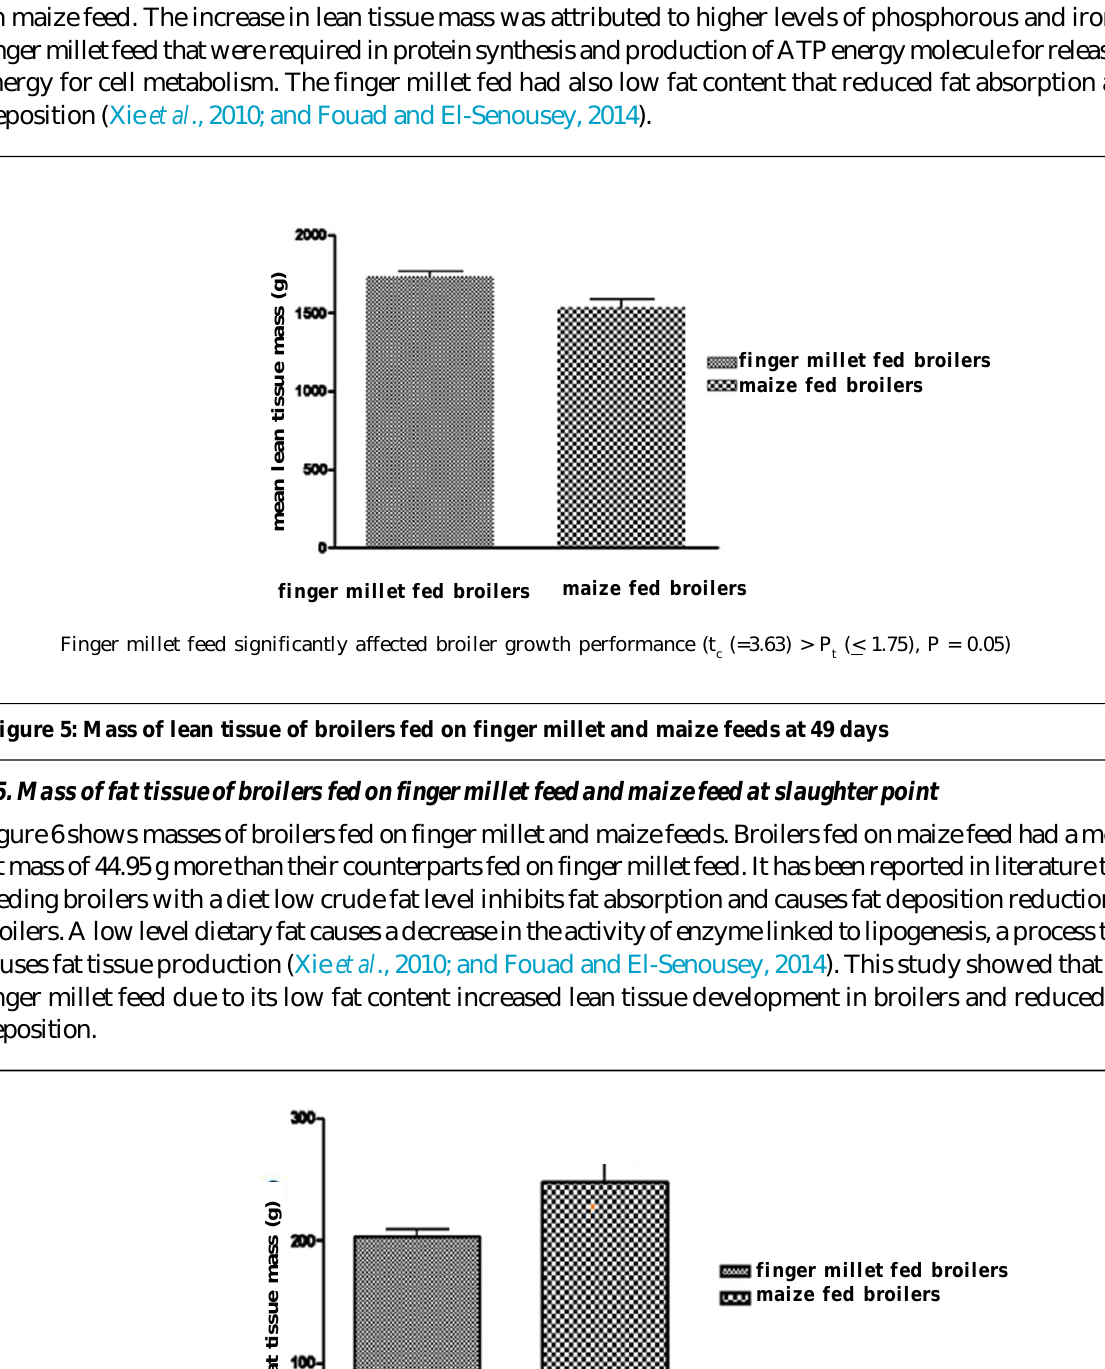
= 2.61) < P (= 6.31), P = 0.05) c t